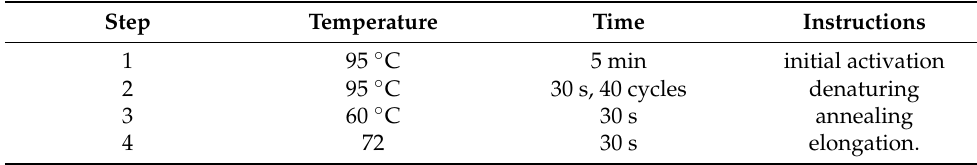
Table 4. PCR reaction